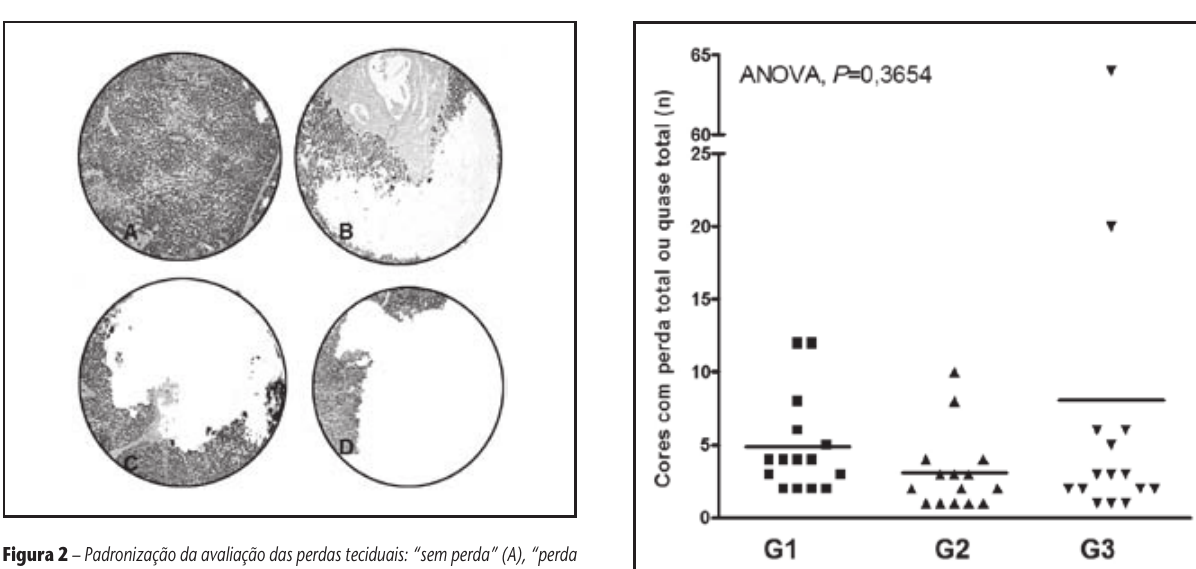
Figura 2 – Padronização da avaliação das perdas teciduais: “sem perda” (A), “perda parcial” (B), “perda quase total” (C) e “perda total” (D)